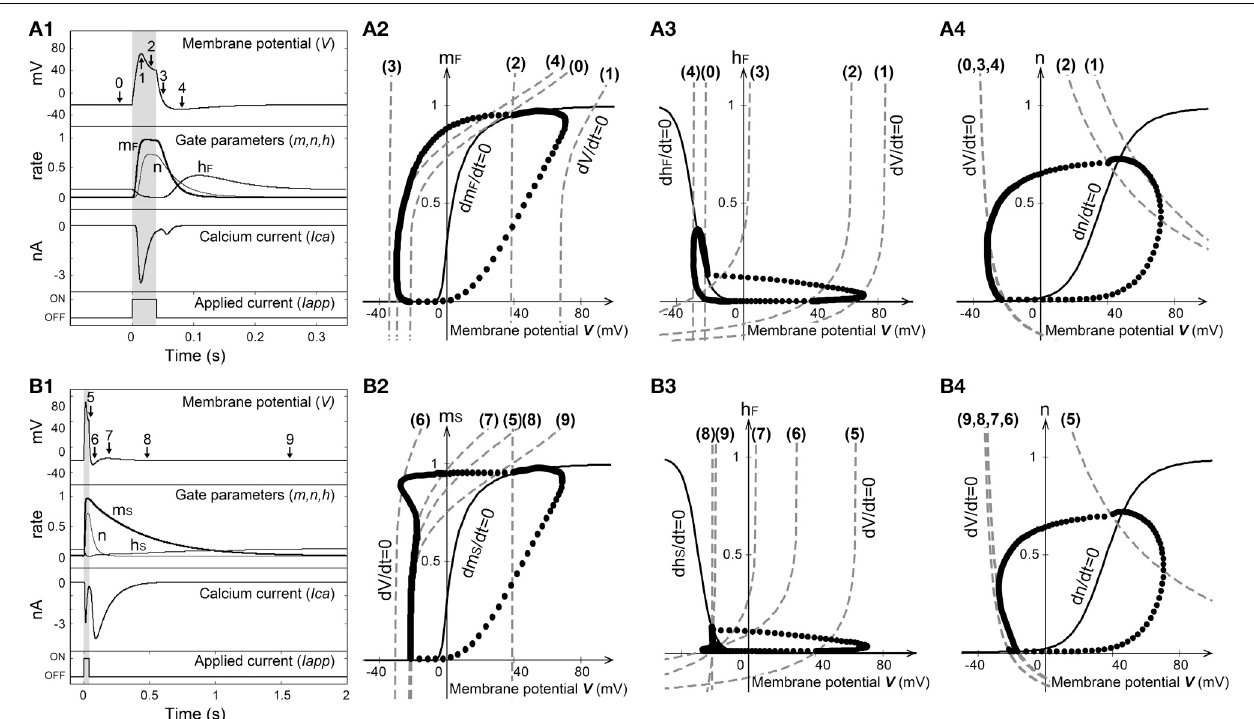
FIGURE 5 | Stimulus-induced membrane potential response in the absence (A) and presence (B) of a Ca 2+ channel with the slow time constant ( E K = − 40mV). (1) Time-courses of the membrane potential, gate parameters, and Ca 2 + current. (2–4) Phase-plane plots of m , h , and